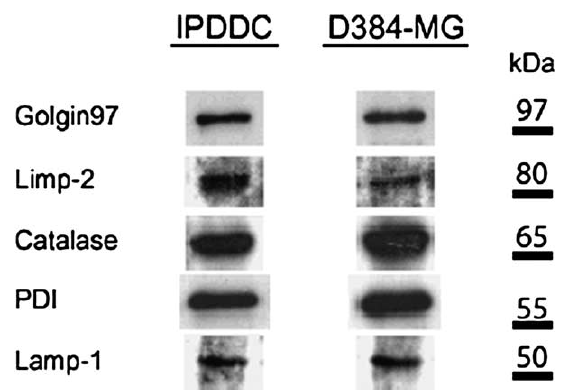
Fig. 2. Expression of organelle specific markers in IPDDC-A2 and D384-MG cells. Immunoblotting of Lamp-1 and Limp-2 for lyso- somes, PDI for ER, Golgin97 for Golgi and Catalase for perox- isomes, was produced using the antibodies described in Table 1. Molecular weights, in kDa, was reported. Immunodetection was per- formed on the following amount of total extracted proteins: Gol- gin97 (20 µg), Limp-2, Lamp-1 and Catalase (50 µg) and PDI (2.5